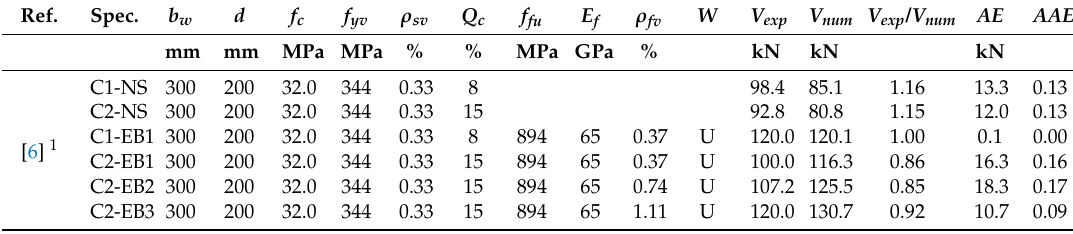
Table 2. Experimental and numerical ultimate shear of strengthened RC beams with corroded stirrups. Ref.